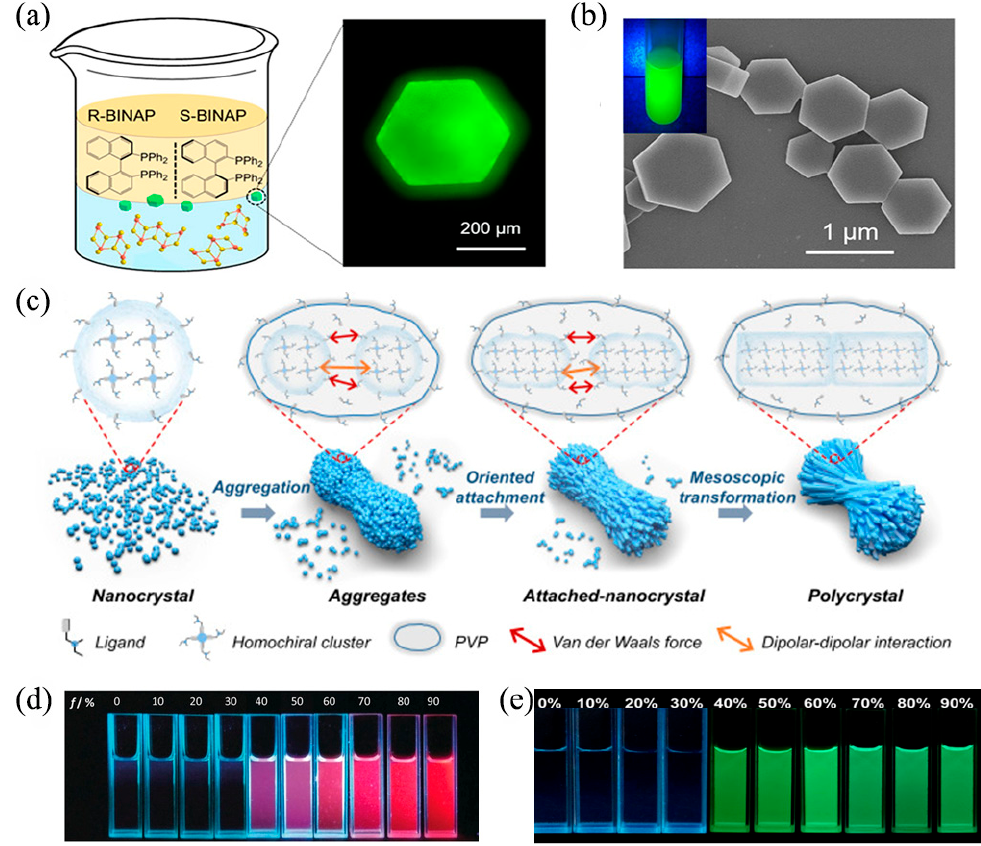
Figure 9. ( a ) Mechanism model of the single crystal growth process of R/S-Cu 2 I 2 (BINAP) 2 hybrid materials (left) and image of the R-Cu 2 I 2 (BINAP) 2 single crystal (right). ( b ) SEM image of R-Cu 2 I 2 (BINAP) 2 hexagon platelet-shaped microcrystals. Reprinted/adapted with permission from Ref. [121]. 2021, copyright American Chemical Society. ( c ) Mechanism model of the biomimetic non-classical crystallization process. Reprinted/adapted with permission from Ref. [95]. 2022, copyright Springer Nature. ( d ) Images of R-Cu 14 in different n-hexane solutions. Reprinted/adapted with permission from Ref. [126]. 2020, copyright Wiley-VCH. ( e ) Images of (Au 4 L 4 ) n in dimethylformamide with 0–90% of H 2 O. Reprinted/adapted with permission from Ref. [96]. 2020, copyright Springer